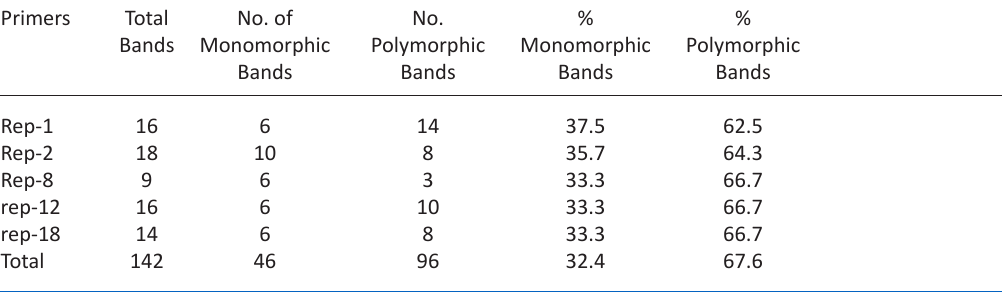
Fig. 4. Amplification of some specific genes producing in some Enterococcus isolates by single PCR. (A) ErmB gene specific for erythromycin resistance with size about of 405 bp. (B) aac(60)-Ie-aph(200)-Ia gene specific for gentamicin with size about of 348 bp. (C) TetL gene specific for tetracycline resistance with size about of 696 bp. (D) Tuf gene specific for Enterococcus spp. with size about of 112 bp. (E) VanA gene specific for vancomycin resistance with size about of 231 bp. And (F) KpsII gene specific for capsule formation in Enterococcus species with size about of 272 bp. First lane on each panel is 100 bp molecular weight Table 3. Polymorphic bands of each genetic primers and percentage of polymorphism in nineteen Enterococcus spp. isolates based on the five rep-PCR primers